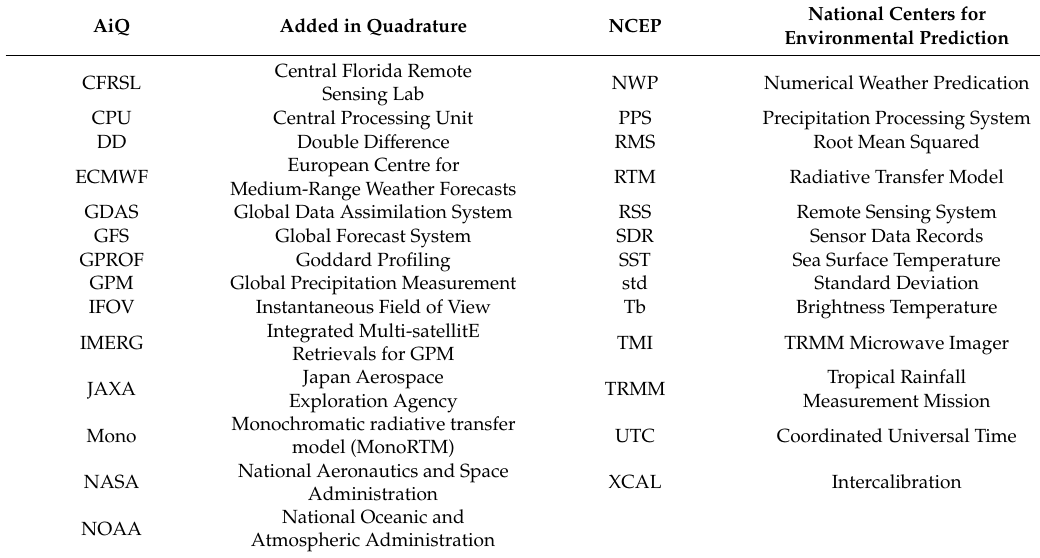
Table A1. List of